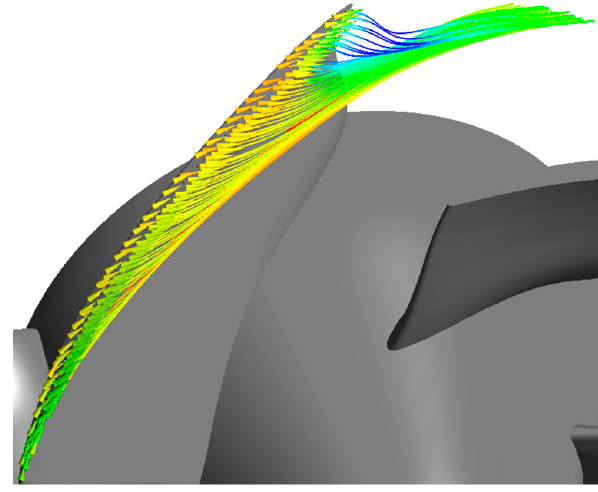
Figure 12. The streamline diagram through the impeller tip under different cavitation